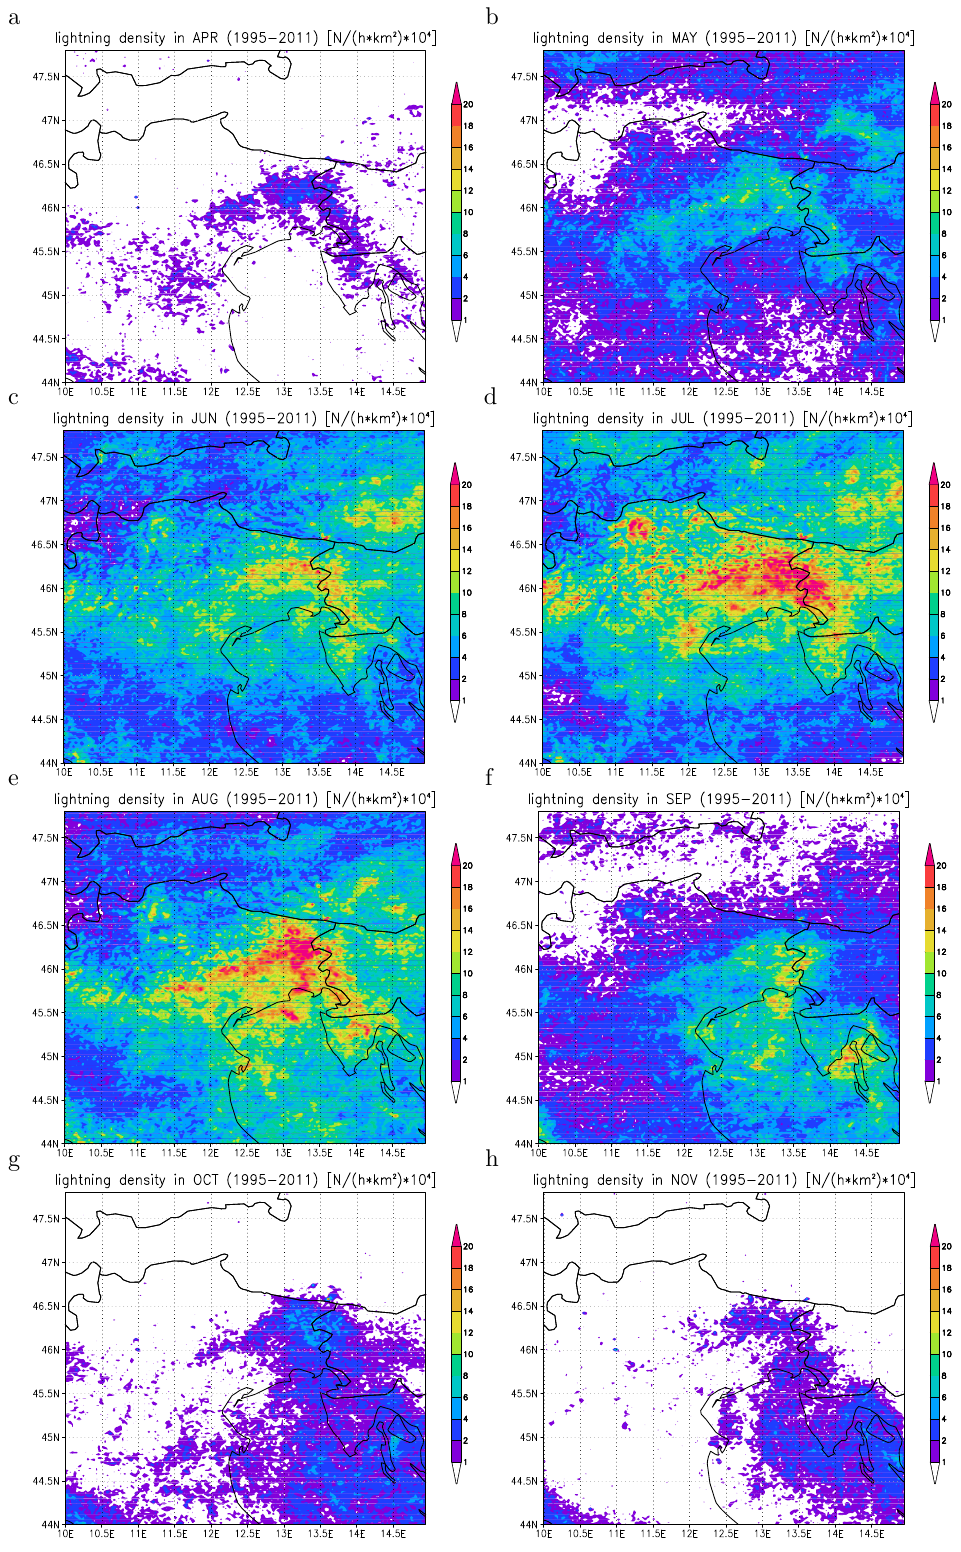
Figure 6. Month-by-month C2G lightning spatial distribution starting from April up to November. The scale is number of lightnings per hour per km 2 times a factor of 10 4 .